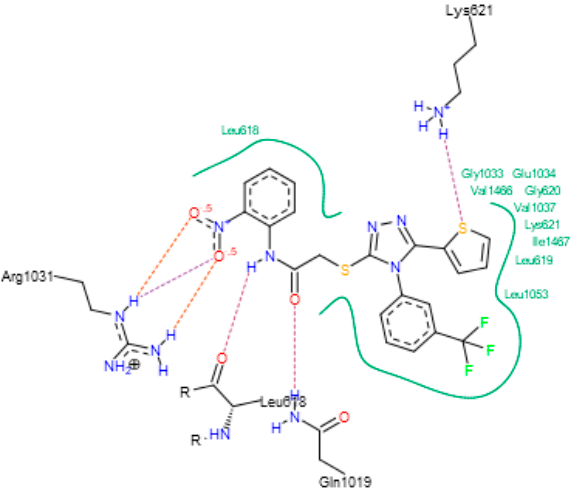
Figure 3. Binding mode of 2 within bacterial RNAP “switch region”.